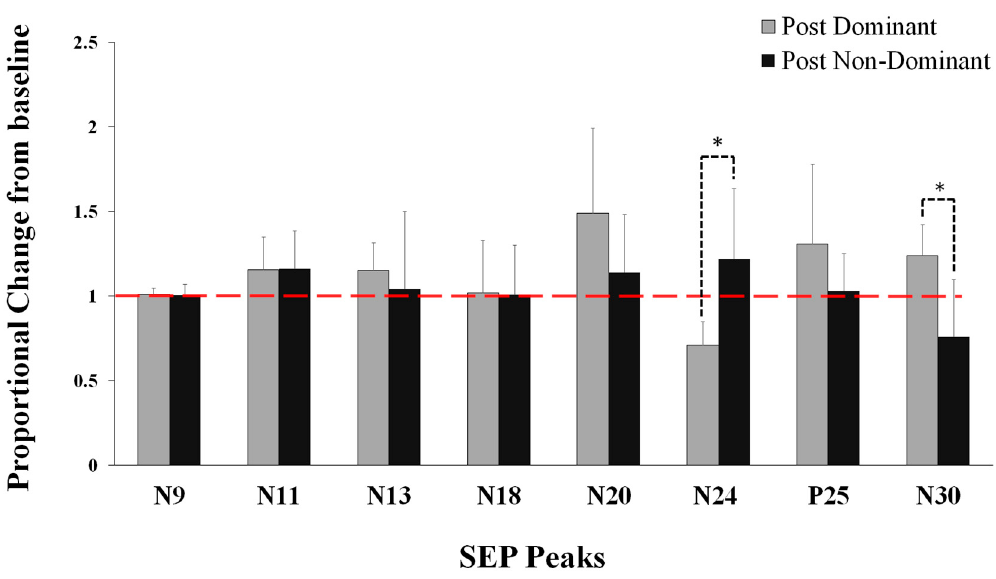
Figure 3. Averaged normalized somatosensory evoked potentials (SEP) peak amplitudes relative to baseline (dotted line), showing Dom vs. Non-Dom groups after motor acquisition tracing task. Note: the significant interactive effects between groups were seen for N24 and N30 SEP peaks (* p < 0.001). Error bars represent SD.